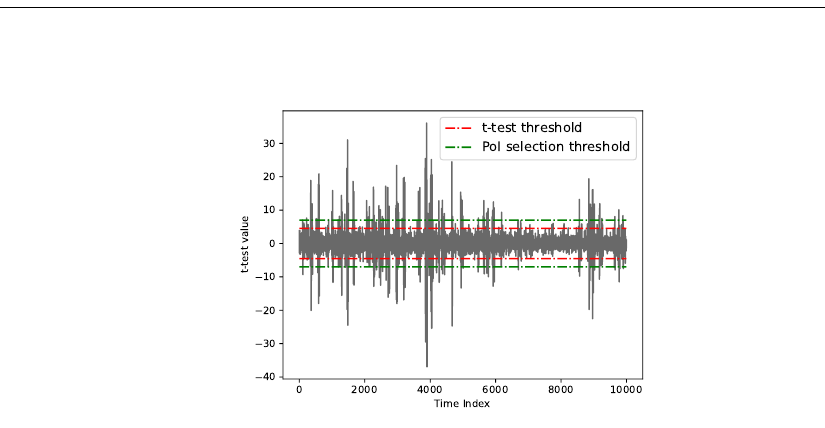
Figure 2: TVLA results for Round5 ( R5ND _ 1KEM _ 5d ) between decoding of valid ( c = 0) and invalid ( c = 1)